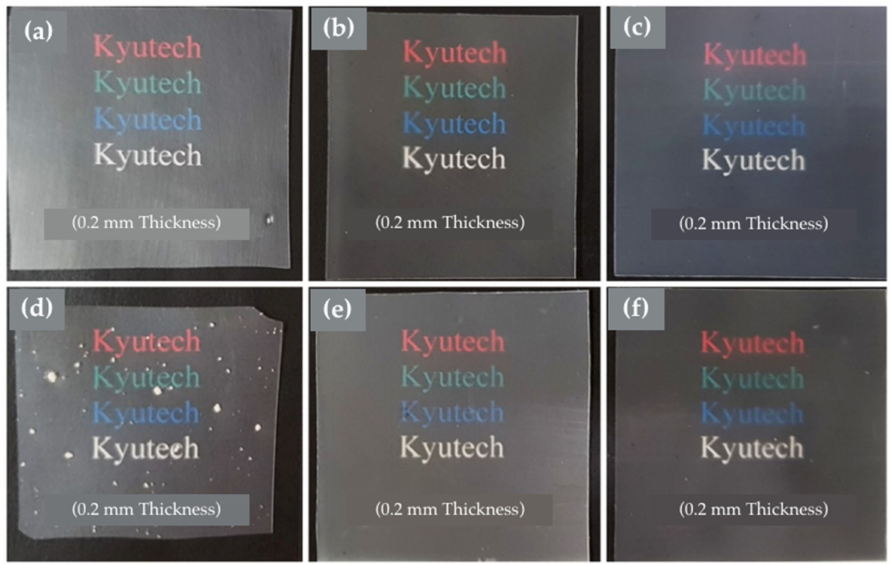
Figure 4. Digital images showing the transparency of ( a ) PP, ( b ) PP-8.75 SS, ( c ) PP-8.75 SP, ( d ) PP-1.25 CNF, ( e ) PP-SS/CNF, and ( f ) PP-SP/CNF.